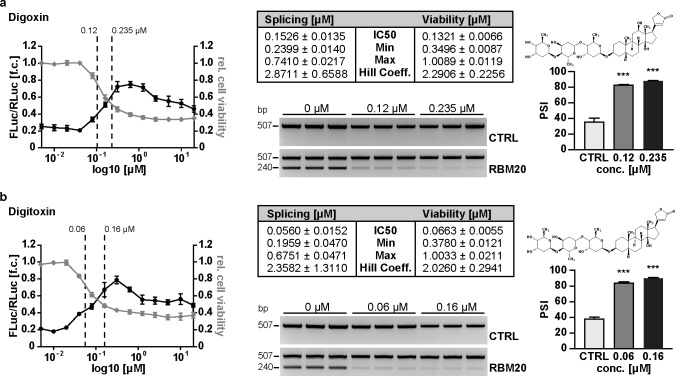
Cardenolides are potent inhibitors of RBM20 dependent titin splicing.Figure layout and panels as described in Fig 3. (a, b) Additional cardenolides not present in the original library were selected to evaluate their potency to inhibit RBM20 dependent titin splicing. The structural analogs digoxin and digitoxin both efficiently inhibit RBM20 mediated splicing. (DLR N = 4; RNA N = 3). ***P<0.001 versus CTRL (Dunnett’s post-test). Data are presented as mean ±SD.